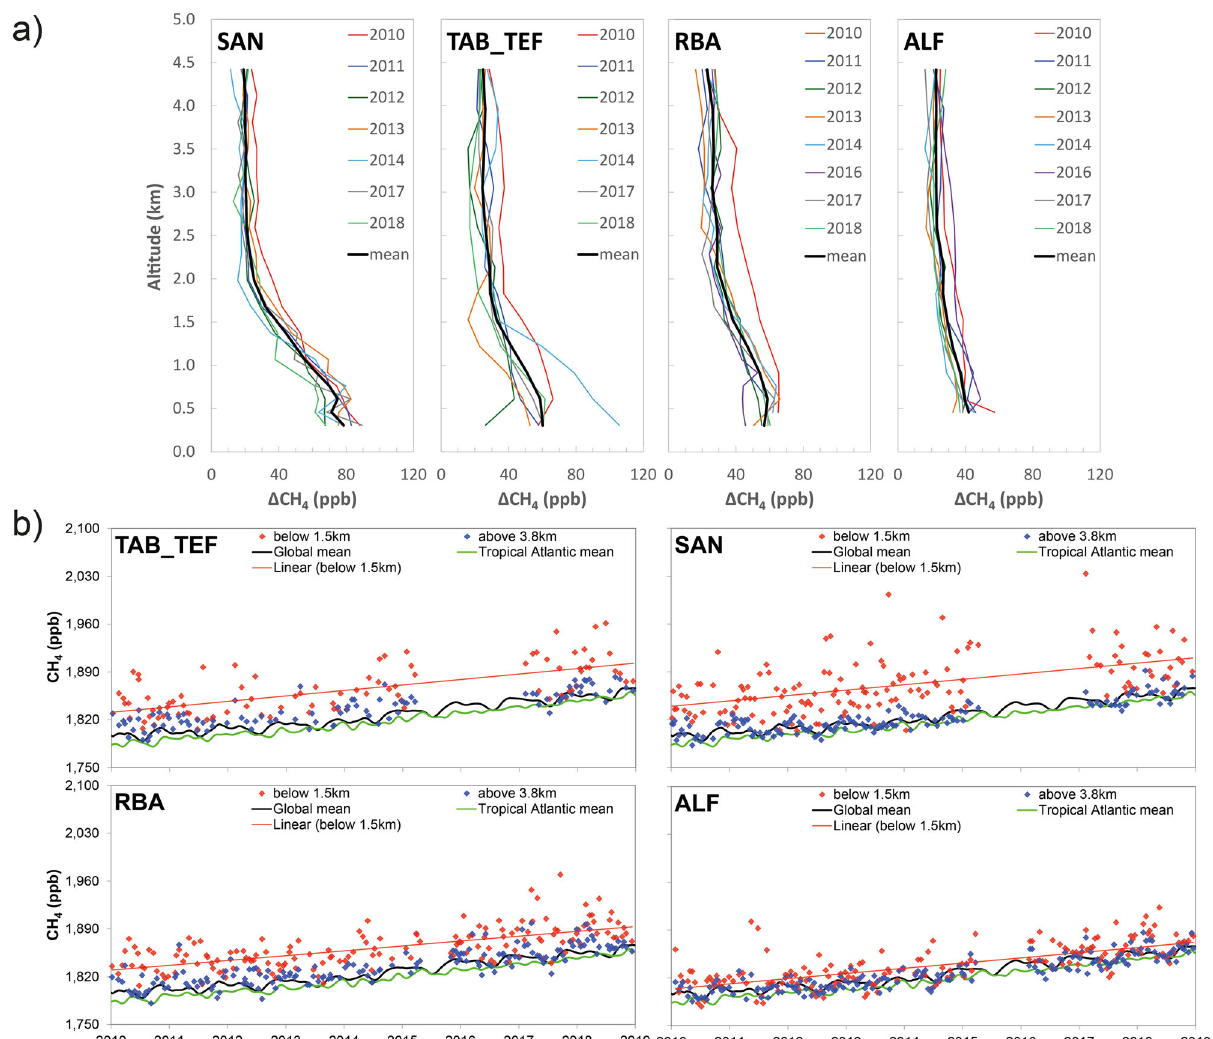
Fig. 2 Annual mean Amazonian CH 4 vertical pro fi les and time series of the below planetary boundary layer, free troposphere and background data. a Annual mean Δ CH 4 (pro fi le minus background mole fraction) of vertical pro fi les measured between 2010 and 2018 (coloured lines) and nine-year mean Δ CH – 2018; black line). b Mean vertical pro fi les PBL (red diamonds) and free troposphere (blue diamonds) CH 4 (2010 and tropical Atlantic means (green; mean of NOAA surface sites ASC and RPB located between 17.5°N and 17.5°S). Background CH 4 time series from NOAA 29